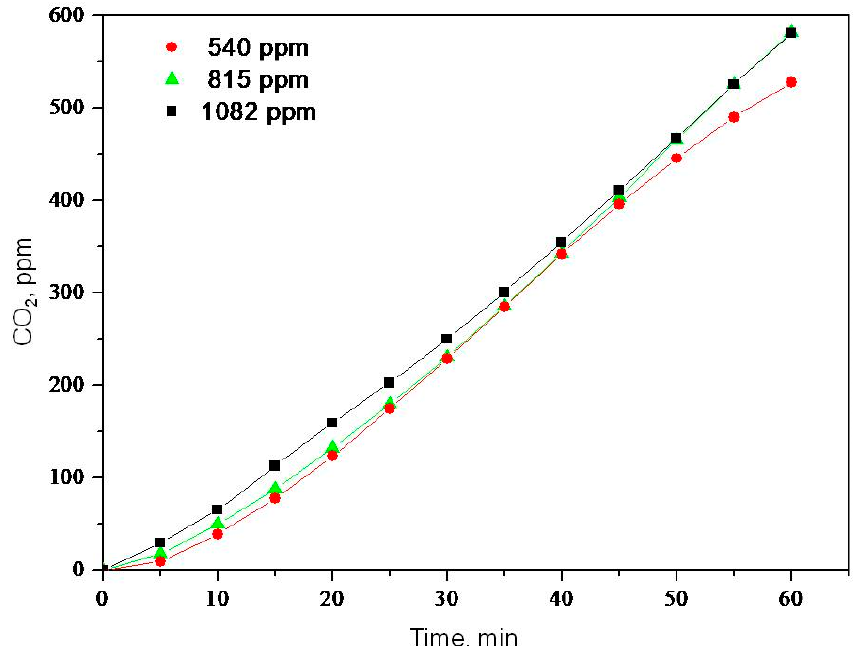
Figure 6. Photocatalytic degradation of methanol (as CO 2 produced) determined at different initial concentrations of the substrate. TiO 2 (P25, Degussa) commercial powder is used. In this case, only three initial substrate concentration values were analyzed owing to the difficulties encountered in manual sampling due to the very high vapor pressure of the methanol. The experimental error is ≤ 10%.